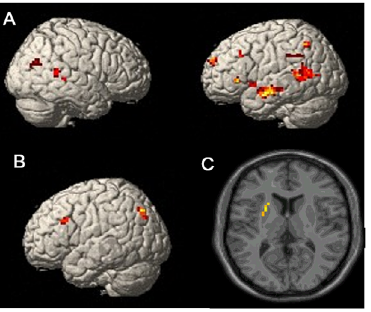
Figure 4. Subsequent Memory Effects. A. Brain activation during correct retrieval of pairs at Test 1: contrast is between those trials that were again correctly recalled on Test 2 vs. those that were not correctly recalled the second time. B. Brain activation during initial encoding of pairs ( i.e. , the study phase): contrast between encoding for trials that were subsequently recalled correctly on Test 1 vs. those that were not. C. Brain activation during re-study of pairs following an incorrect recall: contrast is between items later successfully recalled (on Test 2) vs. those that were not.